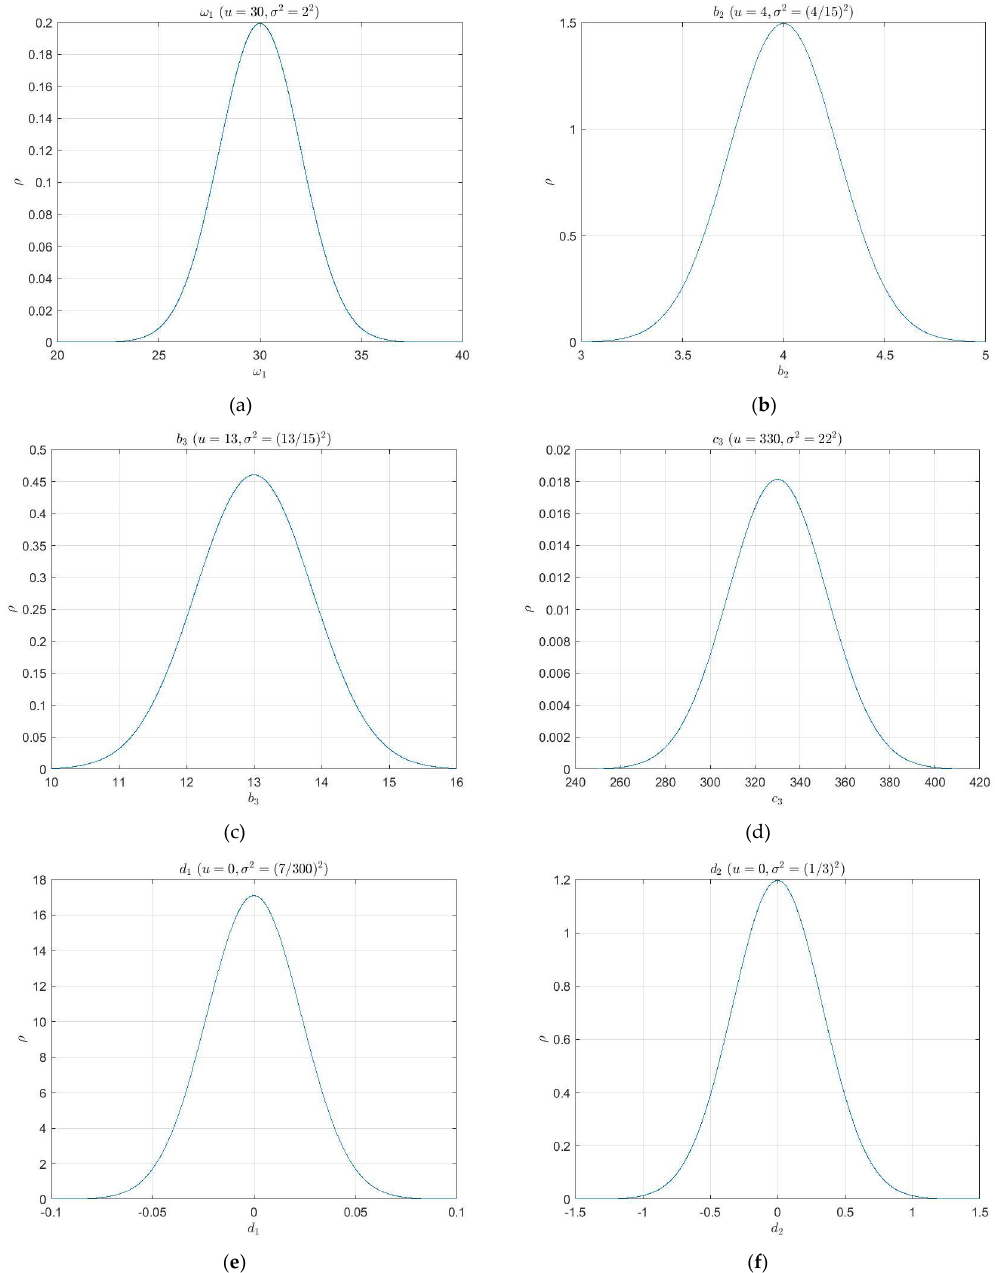
Figure 10. The Gaussian probability density function curves for the six variable parameters: ( a ) The natural frequency of elastic mode 𝜔 1 ; ( b ) The kinetic coefficient 𝑏 2 ; ( c ) The kinetic coefficient 𝑏 3 ; ( d ) The kinetic coefficient 𝑐 3 ; ( e ) The external disturbance of pitch angle 𝑑 1 ; ( f ) The external disturbance of elastic modes. Simulations performed for each set of parameters, and the outputs were analyzed.